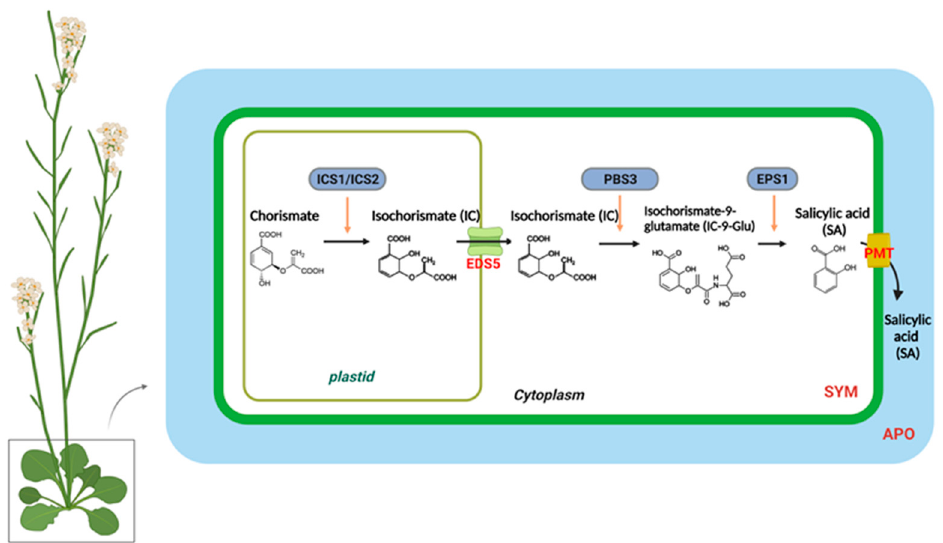
Figure 1. The biosynthesis and transport of salicylic acid in a plant cell. In plastids, chorismite is converted to isochorismate (IC) through the action of an IsoChorismate Synthase (ICS1/2). A MATE transporter called Enhanced Disease Susceptibility 5 (EDS5) transports IC from the plastid to the cytosol. The AvrPphB susceptible 3 (PBS3) catalyzes the conjugation of IC to glutamate (Glu), which results in IsoChorismate-9-Glutamate (IC-9-Glu). IC-9-Glu is then converted to salicylic acid (SA) by Enhanced Pseudomonas Susceptibility 1 (EPS1). SA moves preferentially to the apoplastic compartment (APO) through the plasma membrane transporter (PMT).